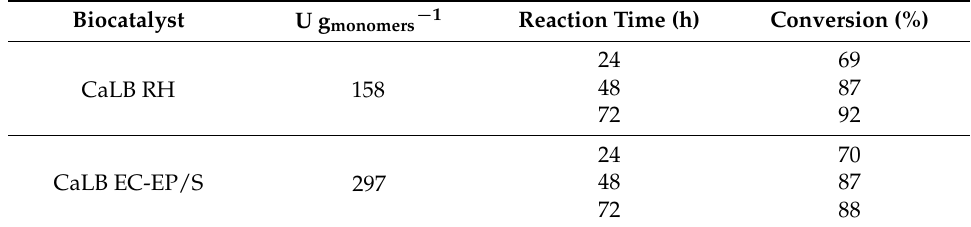
Table 3. Comparison of the results obtained by the polycondensation reaction catalyzed by the two different preparations of immobilized CaLB. Enzymatic units refers to tributyrin hydrolytic activity. Reaction were monitored by 1 H-NMR. Details are available in